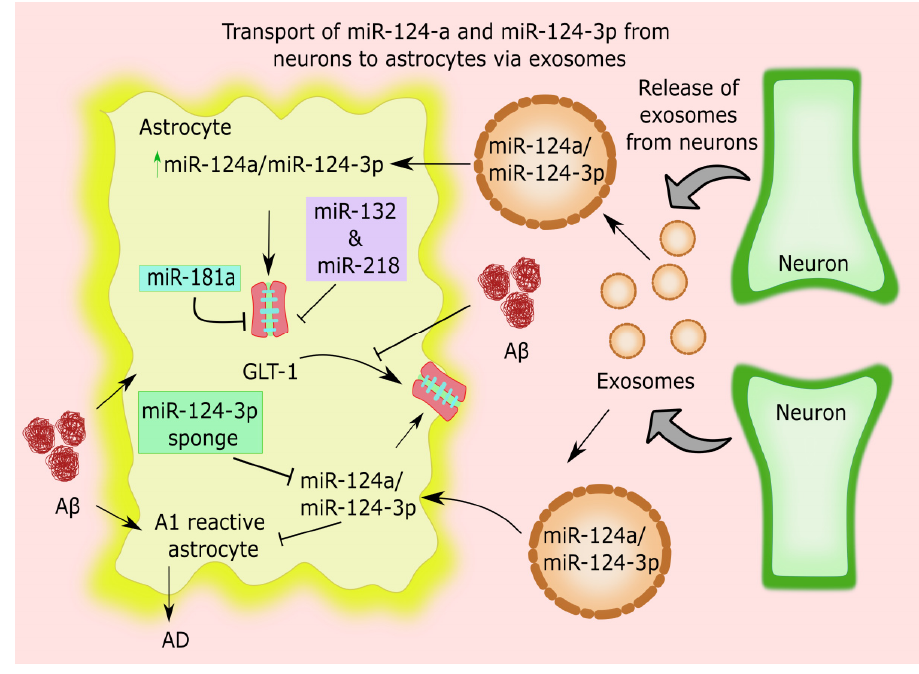
Figure 2. Astrocytic microRNAs in glutamate uptake in Alzheimer's disease. A β markedly decreases GLT-1 expression in the astrocytic plasma membrane by internalizing and mislocalizing GLT-1. miR-181a, miR-132, and miR-218 suppress GLT-1 in astrocytes, which are more prevalent in AD. miR-124a or miR-124-3p are liberated from neuronal EVs and penetrate astrocytes, where they boost GLT1 expression.